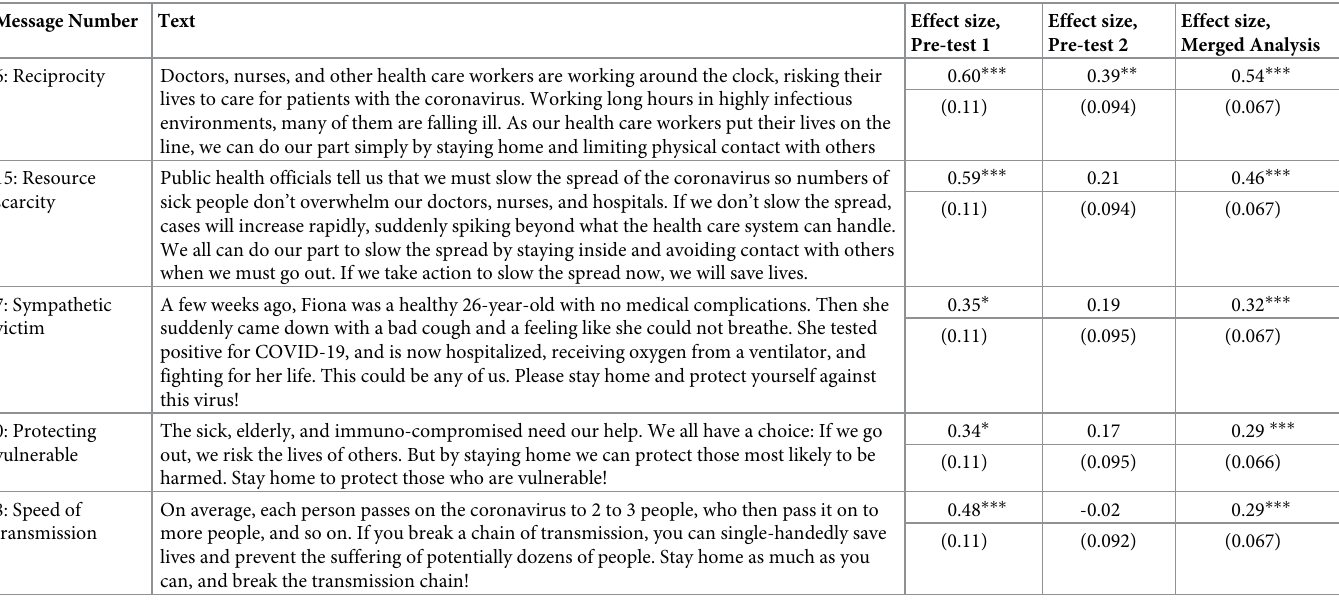
Table 1. Messages that outperformed control in merged analysis of Studies 1 and 2. Message Number